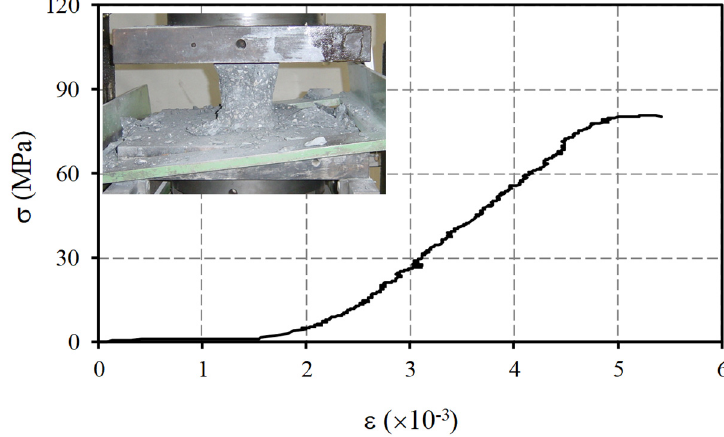
σ ε Figure 3. Uniaxial σ – ε curve for concrete. Figure 3. Uniaxial – curve for concrete. Table 2. Concrete mix design (contents per m 3 ). Table 2. Concrete mix design (contents per m 3